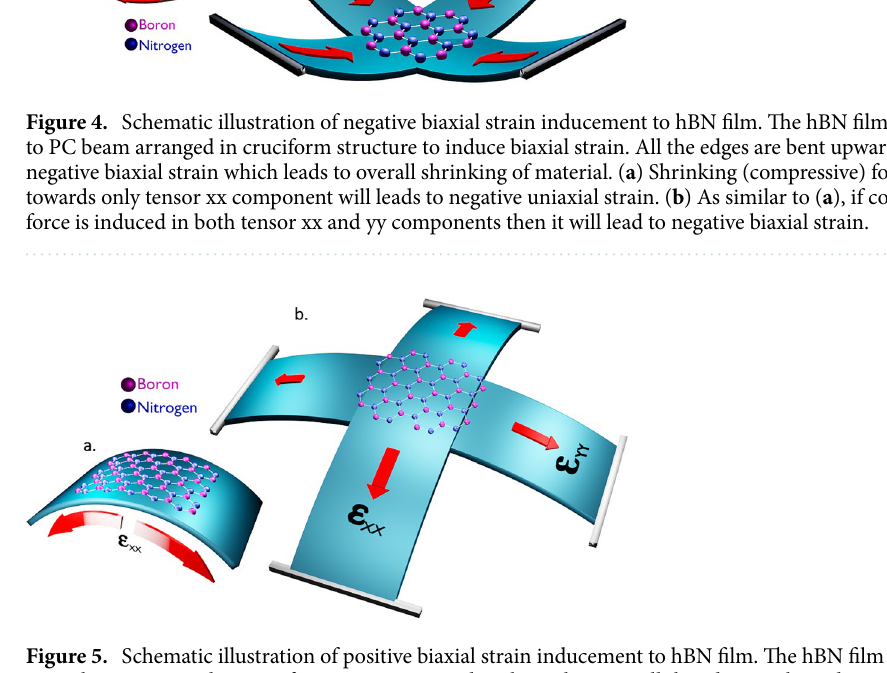
Figure 5. Schematic illustration of positive biaxial strain inducement to hBN film. The hBN film is transferred to PC beam arranged in cruciform structure to induce biaxial strain. All the edges are bent downwards to induce positive biaxial strain which leads to overall stretching of material. ( a ) Expansive (tensile) force induced towards only tensor xx component will leads to positive uniaxial strain. ( b ) As similar to ( a ), if expansive force is induced in both tensor xx and yy components then it will lead to positive biaxial strain.